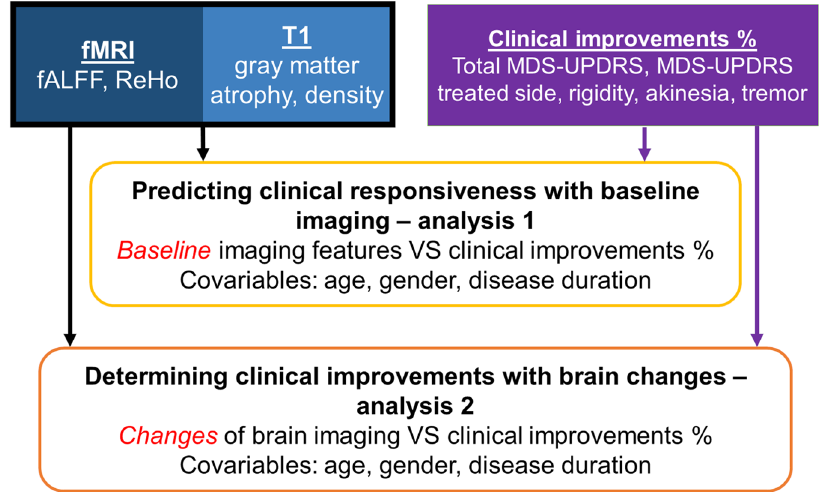
Fig. 1 Flowchart of acquired data and two main study analyses. The purpose of two analyses and the used data for each of them are outlined in the fi gure.